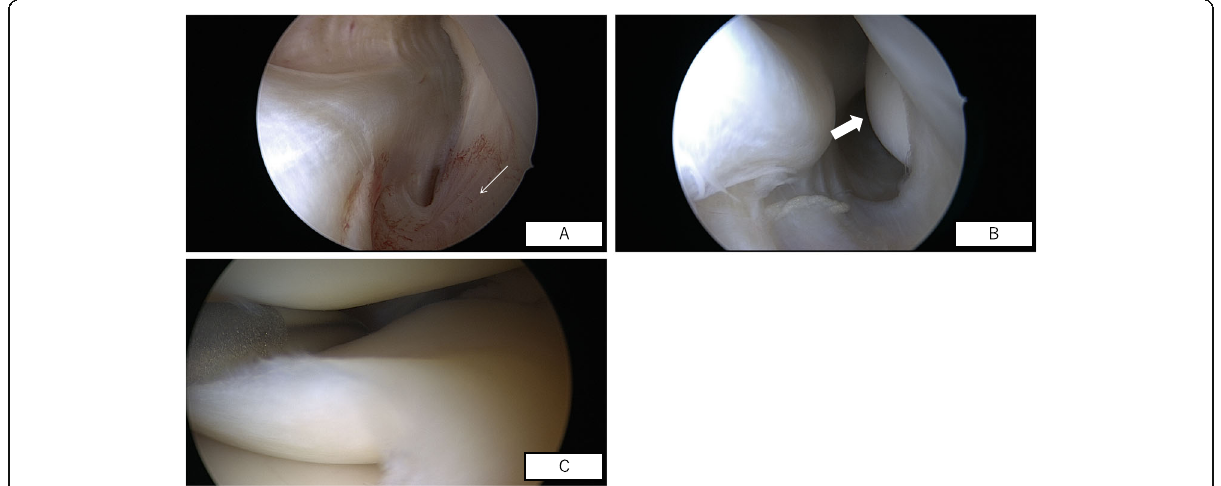
Fig. 1 a . Drive through test positive on a right knee. b . Crescent moon sign. c . hypermobile lateral meniscus on a left knee. Arthroscopic findings of the right knee; the image is viewed from the anterolateral portal. a : Arthroscopic view, lateral gutter, right knee, of torn popliteomeniscal fascicles (white narrow arrow). b : Arthroscopic view, lateral gutter, right knee, showing “ crescent moon sign ” (white broad narrow). c : Arthroscopic view of disruption of the popliteomeniscal fascicles of the lateral meniscus in a left knee. Significant subluxation of the lateral meniscus can